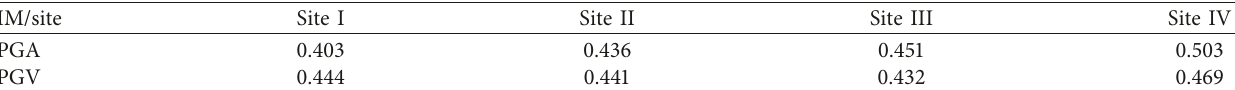
Figure 13: IDA curves in terms of PGV as IM. (a) Site I. (b) Site II. (c) Site III. (d) Site IV. Table 9: Average of σ ln ( EDP )